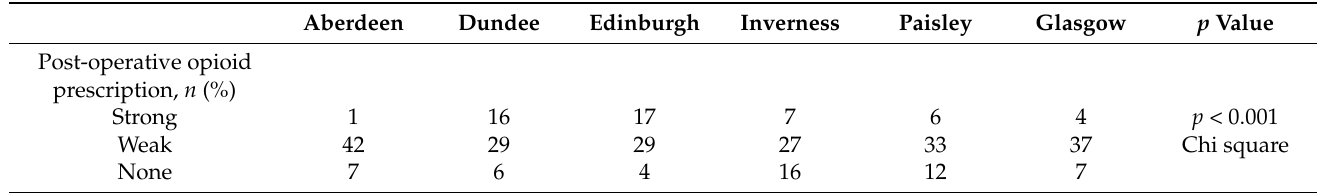
Table 5. Rates of post-operative opioid prescription in the ankle fracture